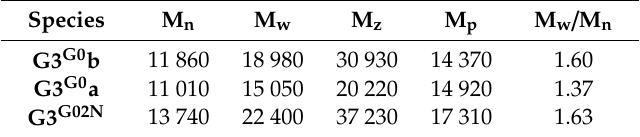
Figure A1. Infrared spectra (from top to bottom) N (red); 1 (brown) (both in KBr pellet); G0 2N (green), G3 G0 (blue), G3 gl (black); (all ATR). Table A2. Molecular weight parameters determined using GPC (see Figure A2 for description).